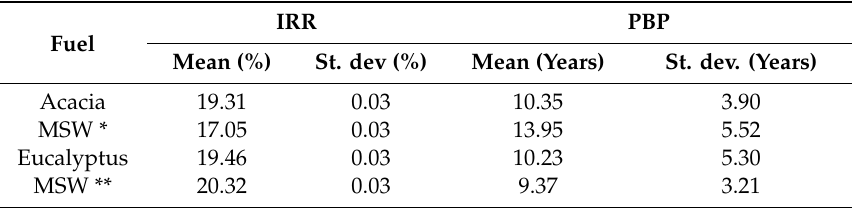
Table 10. IRR and PBP probability distributions for the four studied fuels.